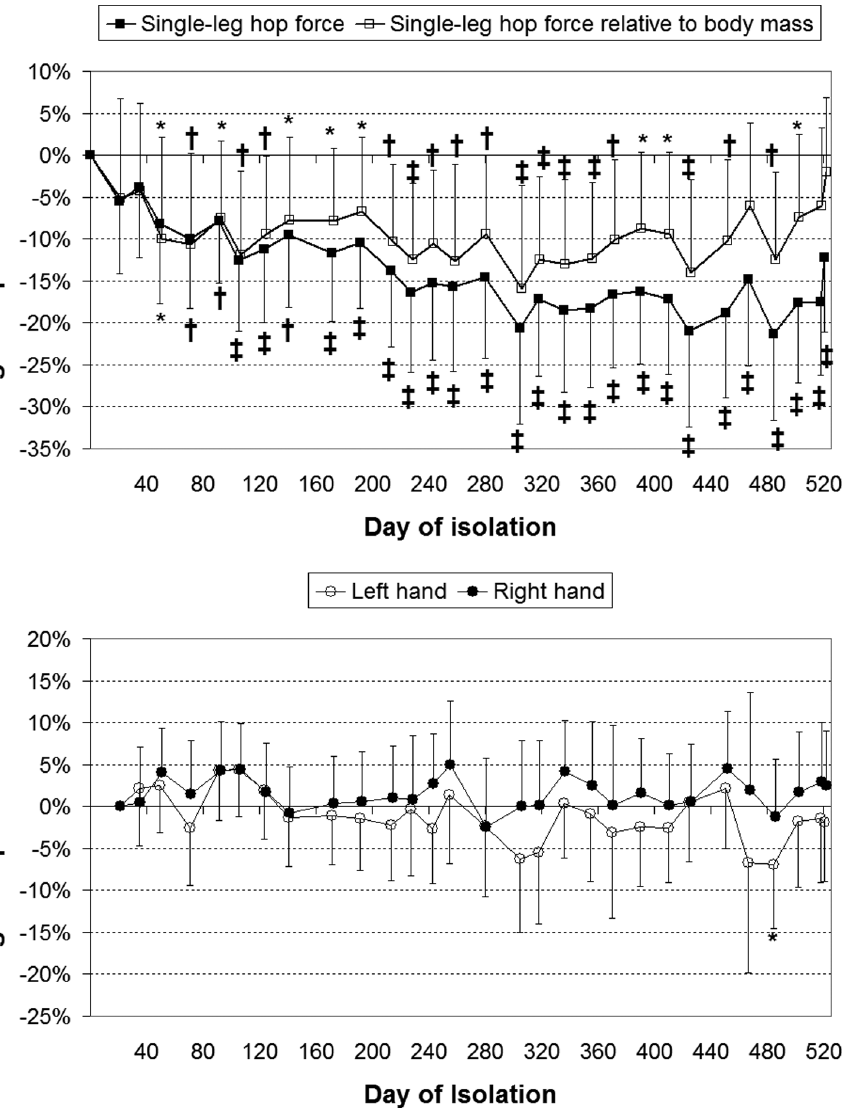
Figure 4. Reductions in single-leg hop force (top) but not grip force (bottom). Values are mean (SD) percentage change compared to first measurement. *: p , 0.05; { : p , 0.01; { : p , 0.001 and give the significance of the